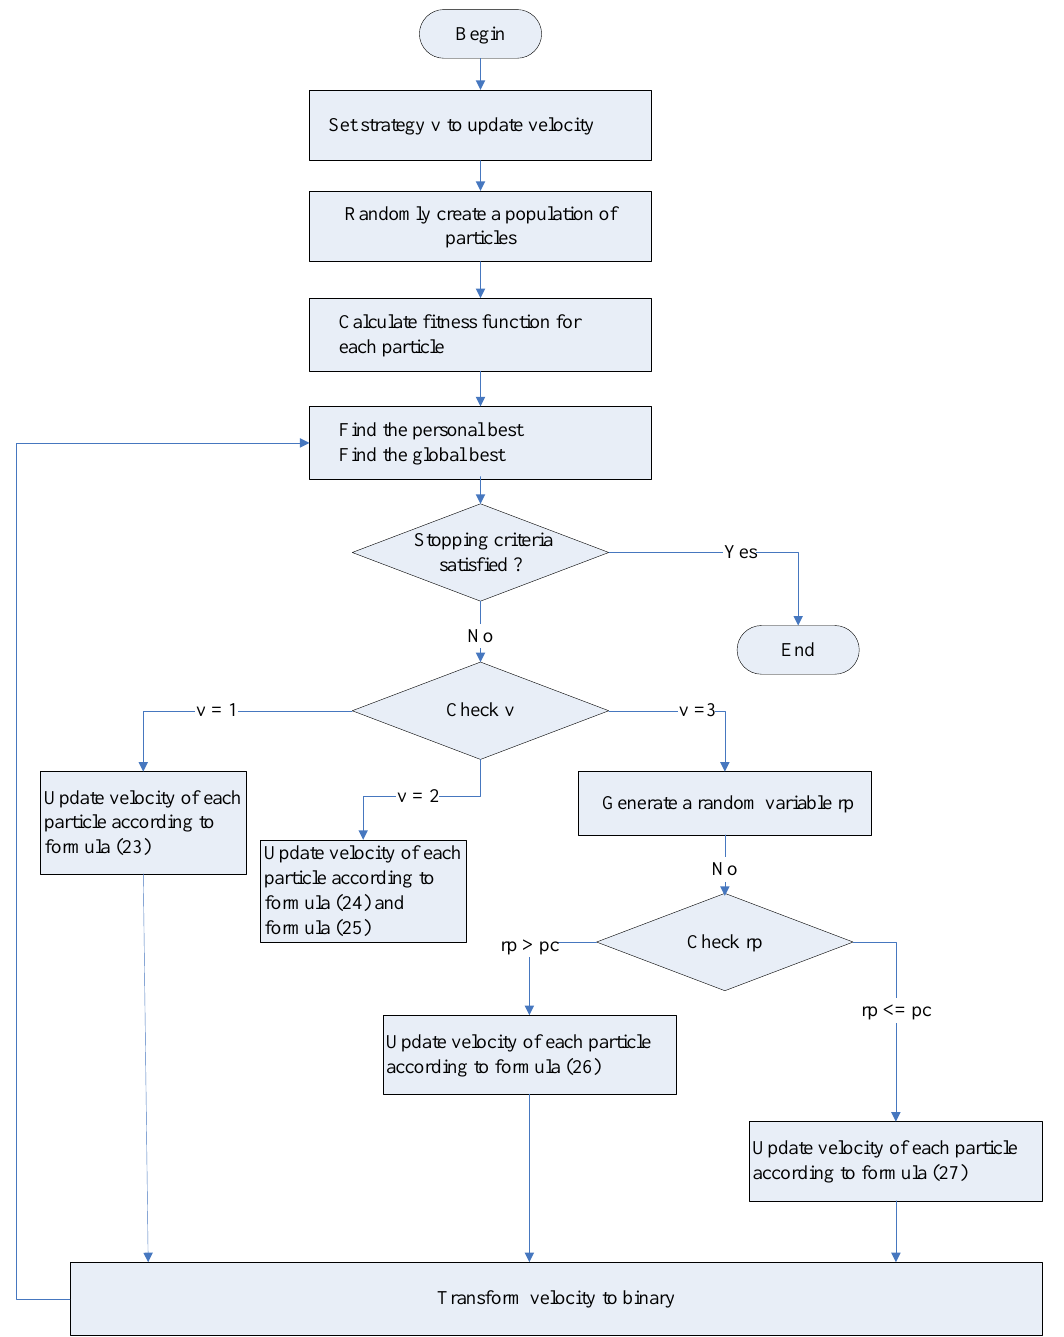
Figure 2. A flow chart for the three variants of the PSO algorithm with velocity update strategy v .